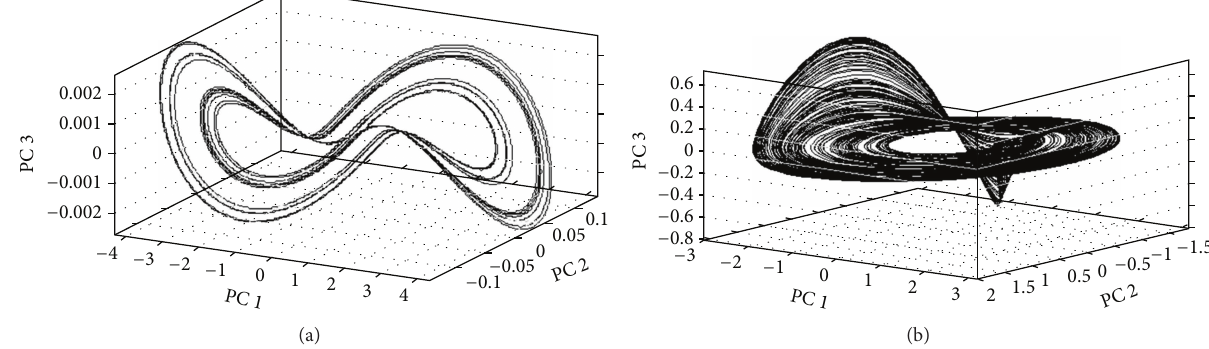
Figure 3: (a) Three-dimensional view of the Lorenz model attractor; (b) three-dimensional view of the Rossler model attractor.